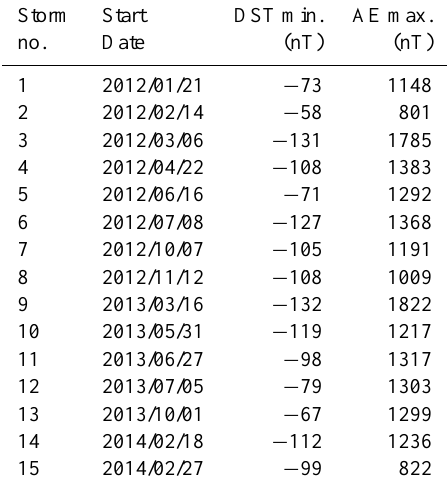
Table 2. Summary table indicating the geomagnetic storm events used in this